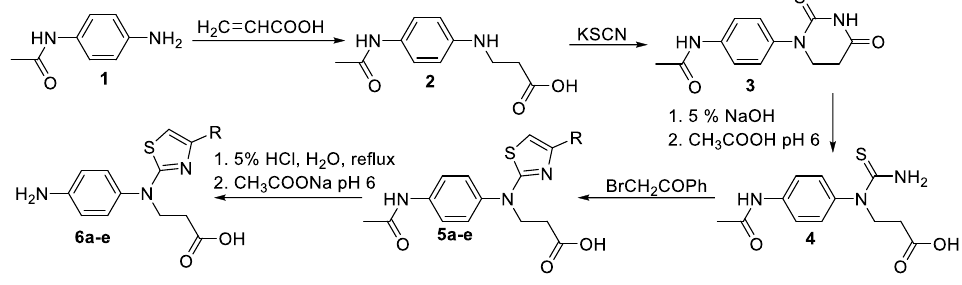
Table 1. Reaction conditions for the synthesis of compound 2 .